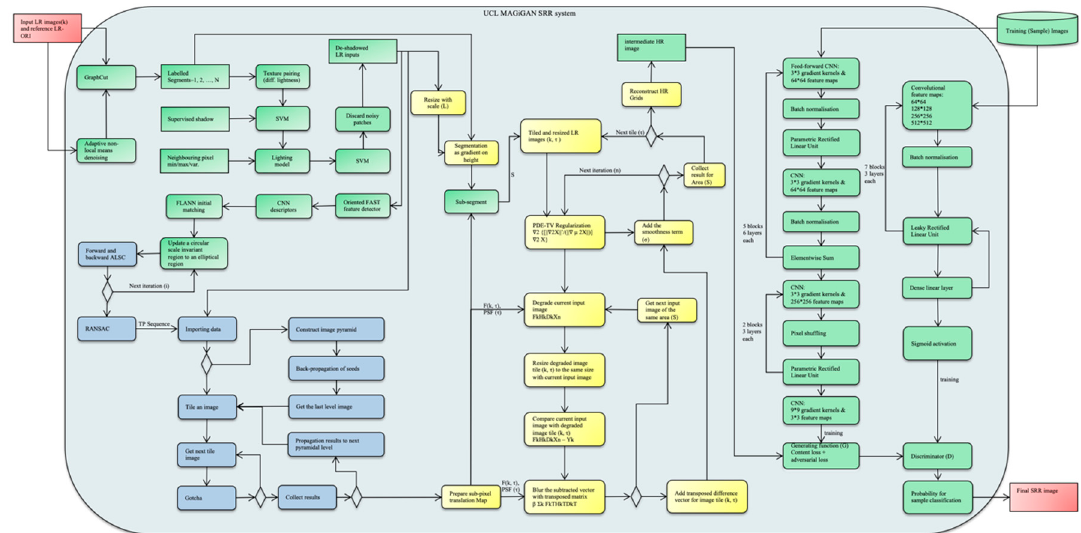
Figure 2. Detailed flowchart of the University College London (UCL) MAGiGAN SRR system (full resolution figure is included in the Supplementary Materials). The two red boxes stand for the input low-resolution (LR) images and final output SRR image, respectively. The green boxes are the new developments within the CEOI SuperRes-EO project. The yellow and blue boxes are components from the original gotcha partial differential equation based total variation (GPT) SRR system. Both the green and yellow boxes are ported onto a graphics processing unit (GPU). The blue boxes for the Gotcha process remain running on the multi-core central processing units (CPUs).